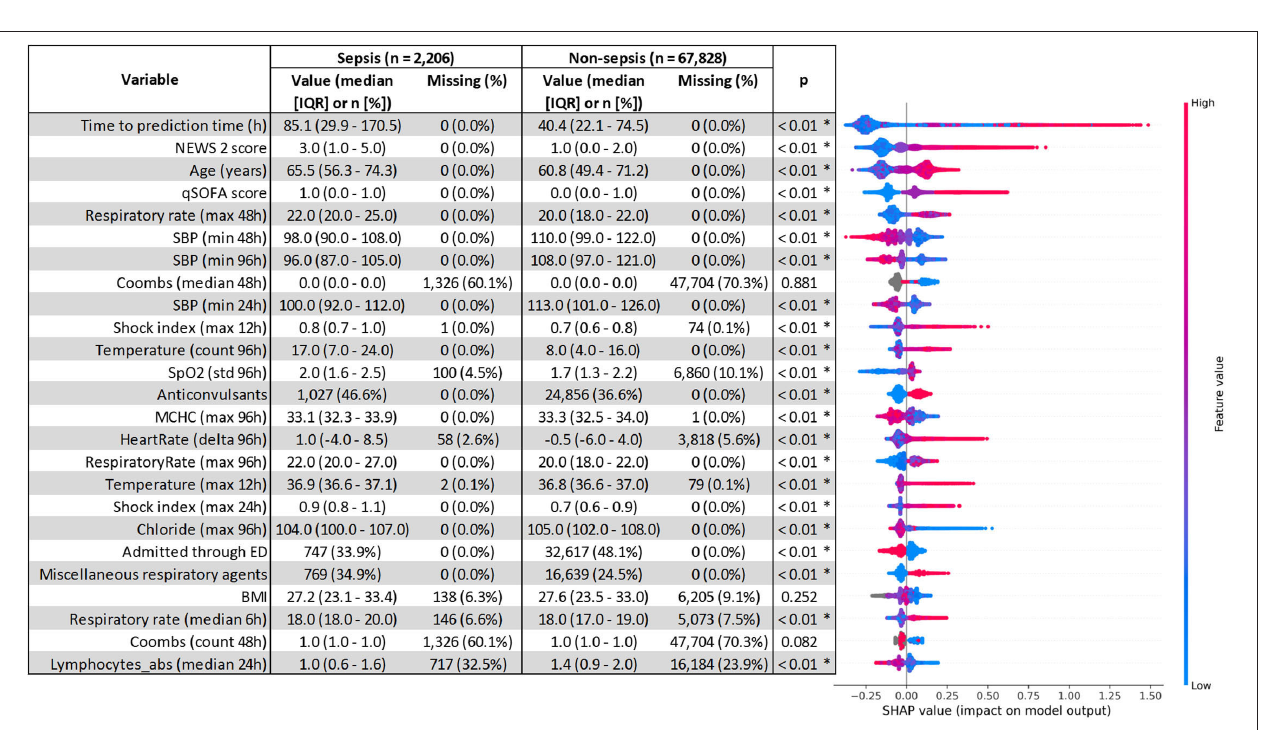
Frontiers in Digital Health |